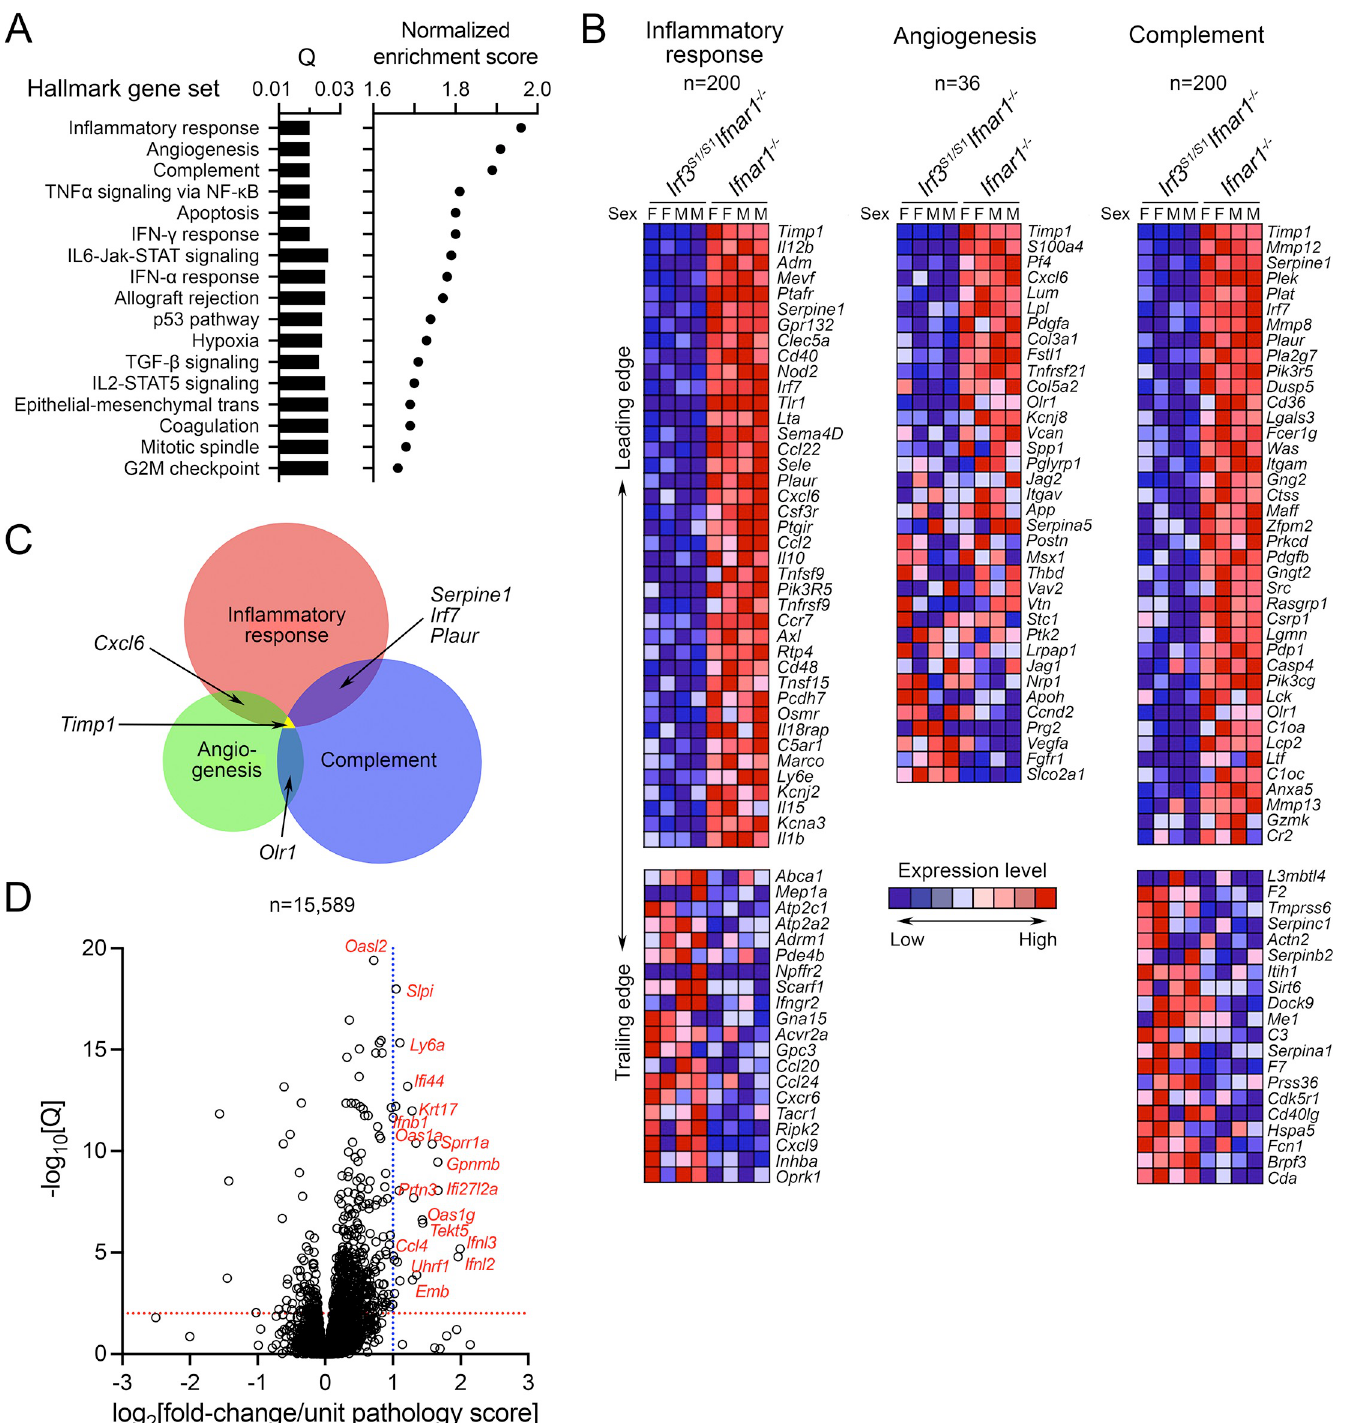
Fig 5. Differentially expressed intrahepatic transcripts in HAV-infected Irf3 S1/S1 Ifnar1 -/- versus Ifnar1 -/- mice. (A) Gene Set Enrichment analysis showing false discovery rate (Q) and normalized enrichment scores of hallmark gene sets most enriched for differentially expressed genes. (B) Heat maps reflecting transcript abundance of the top 40 genes in the leading edges, and bottom 20 genes in the trailing edges, of the hallmark “inflammatory response” and “complement” gene sets, and all genes in the hallmark “angiogenesis” gene set. The number of genes in each gene set is shown at the top. (C) Venn diagram showing overlap between genes in the leading edges of the hallmark gene sets shown in panel B. (D) Volcano plot showing differential expression of genes in HAV-infected Irf3 S1/S1 Ifnar1 -/- and Ifnar1 -/- mice relative to the liver tissue pathology score as a continuous variable (see S1H in S1 Table). Data were conditioned for sex prior to analysis.